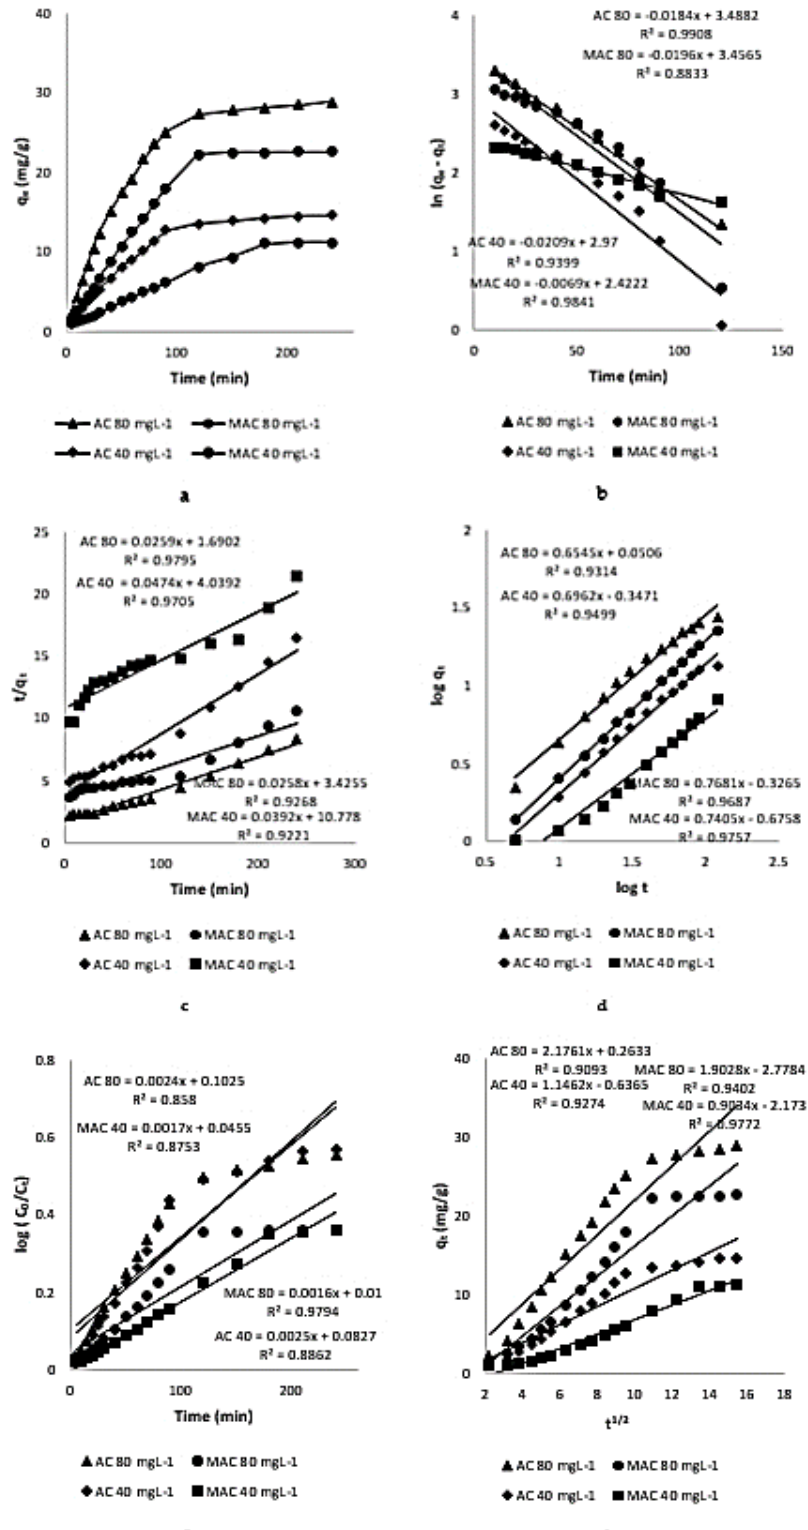
Figure 9. Kinetics of adsorption of AZM on AC and MAC ( a ) Kinetic plots ( b ) Plots of kinetics of pseudo-first-order ( c ) Kinetic plots of pseudo-second-order ( d ) Kinetic plots of power function ( e ) Natarajan and Khalaf kinetic plots ( f ) Intra-particle diffusion plots.